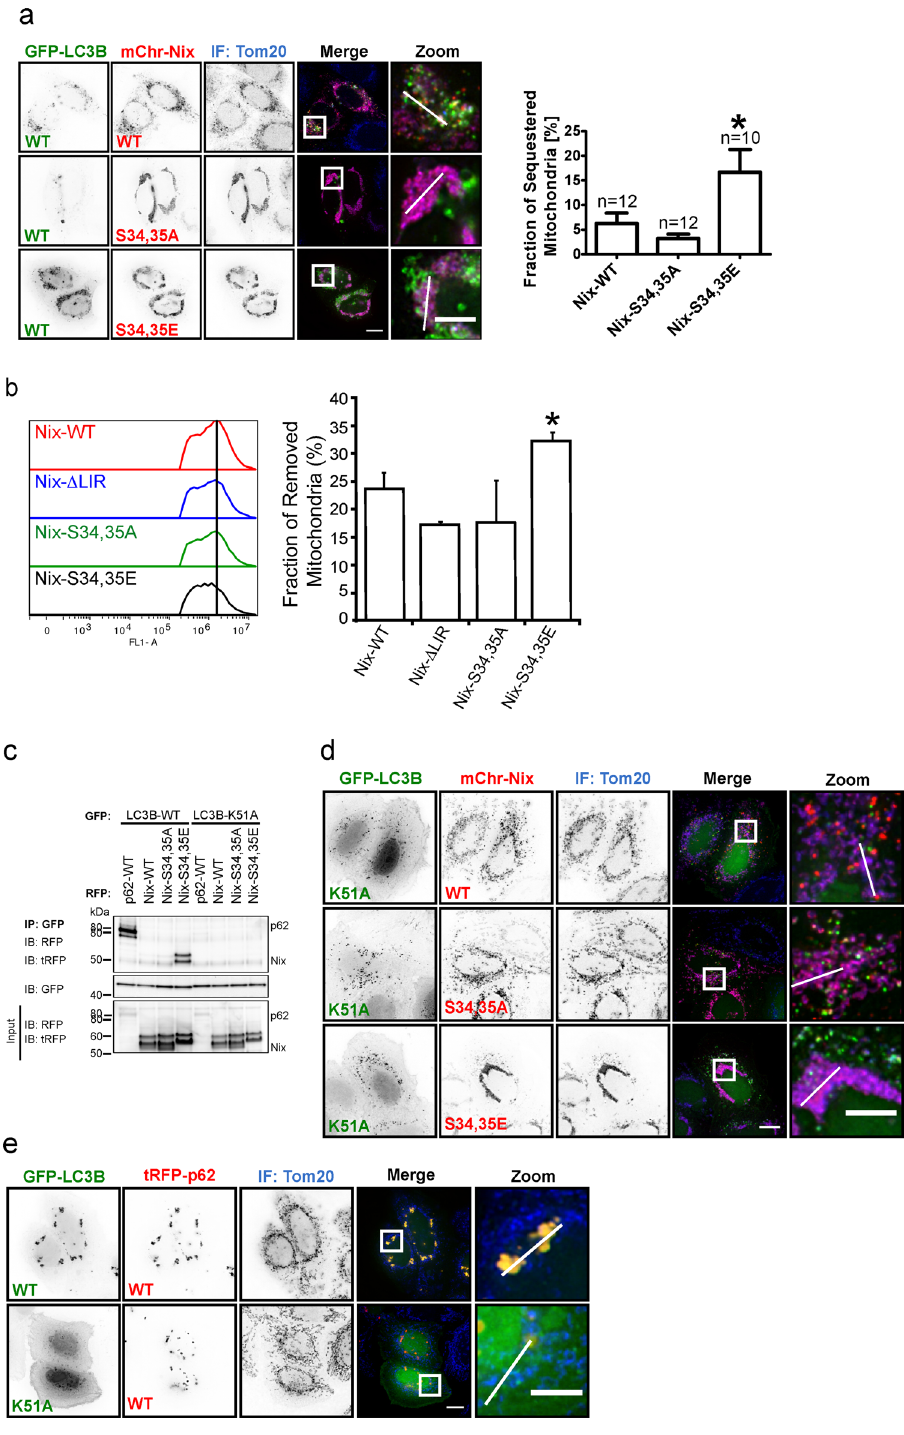
Figure 4. Phosphorylation of the Nix LIR influences the initation of mitophagy and Nix:LC3B interaction depends on LC3B Lys51. ( a ) Hela cells coexpressing GFP-LC3B wild type and Nix wild type or mutants, immunostained (IF) for mitochondrial marker Tom20. GFP-LC3B shows colocalization with RFP-Nix and enhanced colocalization with S34,35E mutant. RFP-Nix S34,35A does not colocalize with GFP-LC3B. Analysis of fraction of sequestered mitochondria is depicted on the graph. ( b ) Analysis of mitochondrial removal is determined by flow cytometry using GFP-Nix, Δ LIR, S34,35A and S34,35E mutants ( c ) Immunoprecipitation of GFP-LC3B wild type or GFP-LC3B K51A in cells co-expressing tRFP-p62 wild type, RFP-Nix wild type, S34,35A and S34,35E mutant. GFP-LC3B K51A fails to coimmunoprecipitate with p62, Nix wild type and mutants. ( d ) GFP-LC3B K51A does not colocalize with Nix wild type or mutants. ( e ) Hela cells coexpressing GFP-LC3B wild type or K51A mutant and RFP-p62, immunostained (IF) for Tom20. Scale bar 10 µ